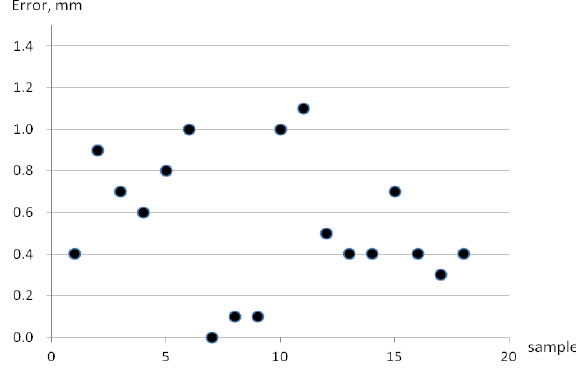
Fig. 11. Camera measured depth versus shifted